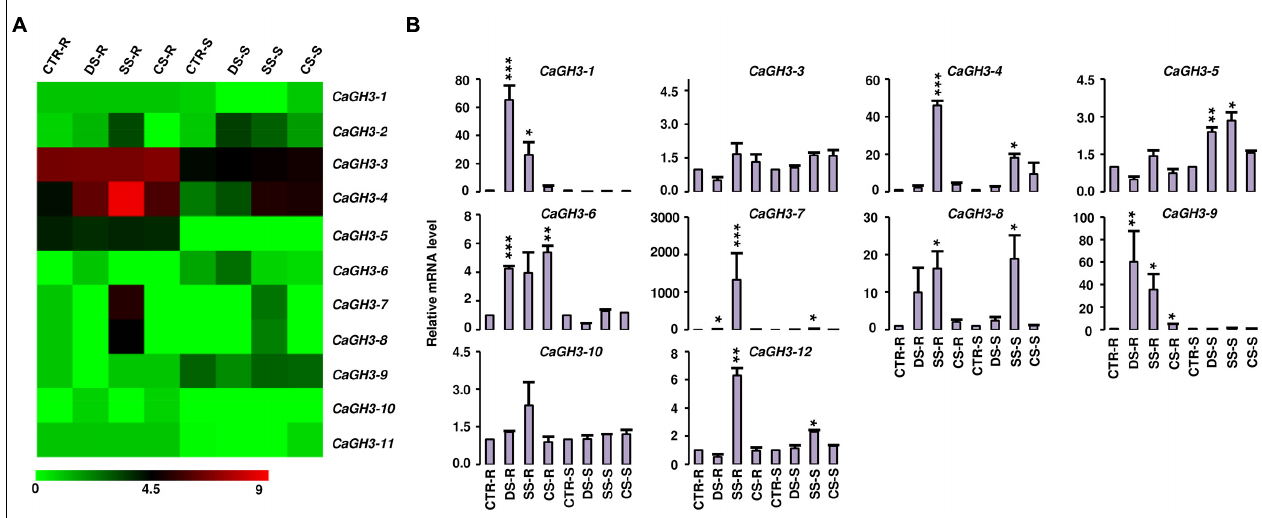
indicate standard error of mean. DS-R : desiccation stressed root, SS-R, salt stressed root; CS-R, cold stressed root; DS-S, desiccation stressed shoot; SS-S, salt stressed shoot; CS-S, cold stressed shoot. Data points marked with asterisk (* P ≤ 0.05, ** P ≤ 0.01, and *** P ≤ 0.001) indicate statistically significant difference between control and stress